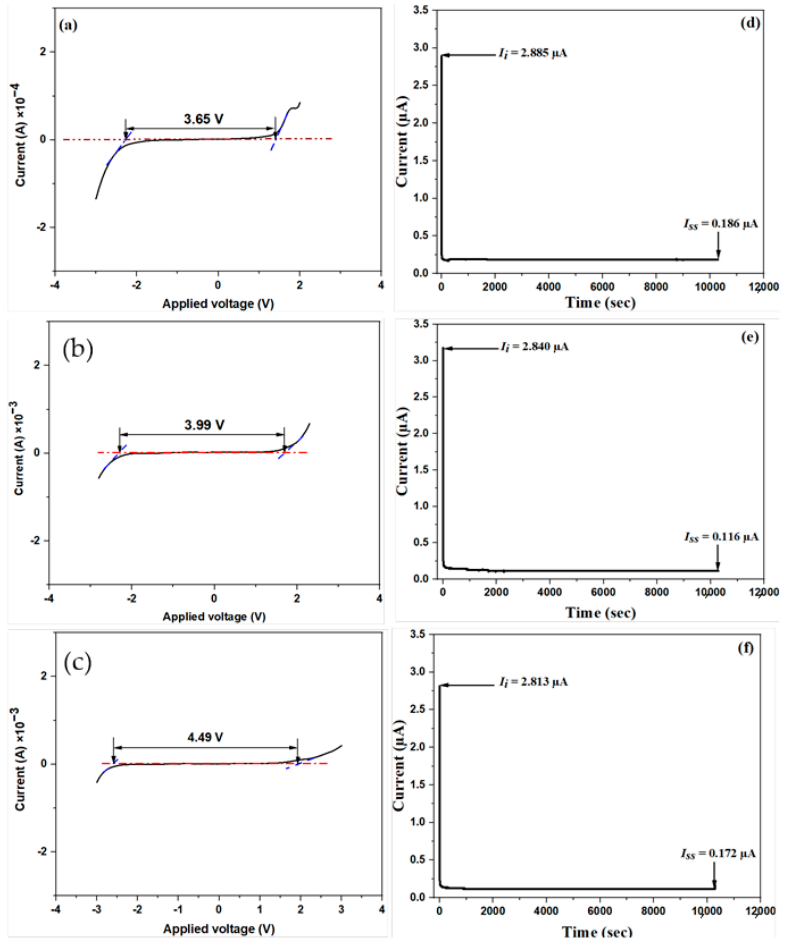
Figure 6. LSV curves showing the electrochemical stability window of the selected MC/PC/K 3 PO 4 - based SBEs: ( a ) unplasticized (SC0), ( b ) SC50, ( c ) SD50, and ( d – f ) TNM of the same samples (SC0, SC50, and SD50), showing the initial and steady-state currents. Table 4. Potential window values for MC/PC/K 3 PO 4 /glycerol SBEs.